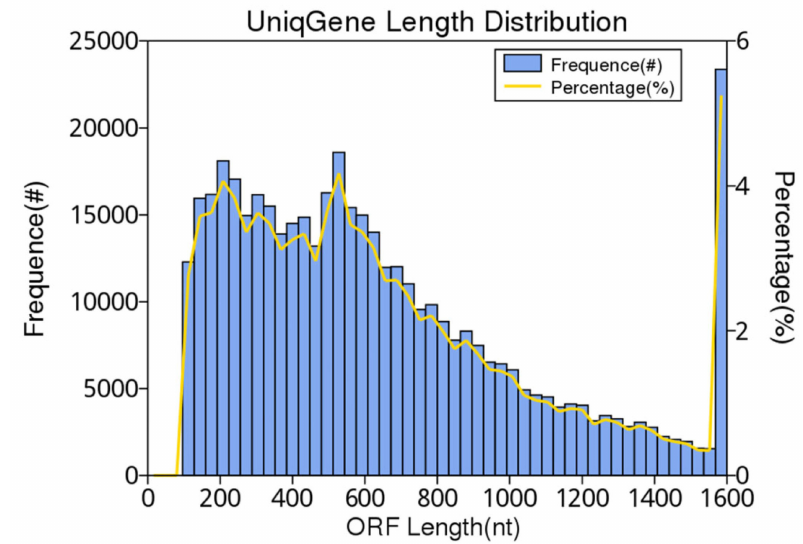
Figure 2. Gene catalogue length distribution. The first vertical axis (Frequence (#)) represents the number of scaftigs; the second vertical axis (Percentage (%)) represents the percentage of the number of scaftigs; the horizontal axis represents the length of scaftigs.